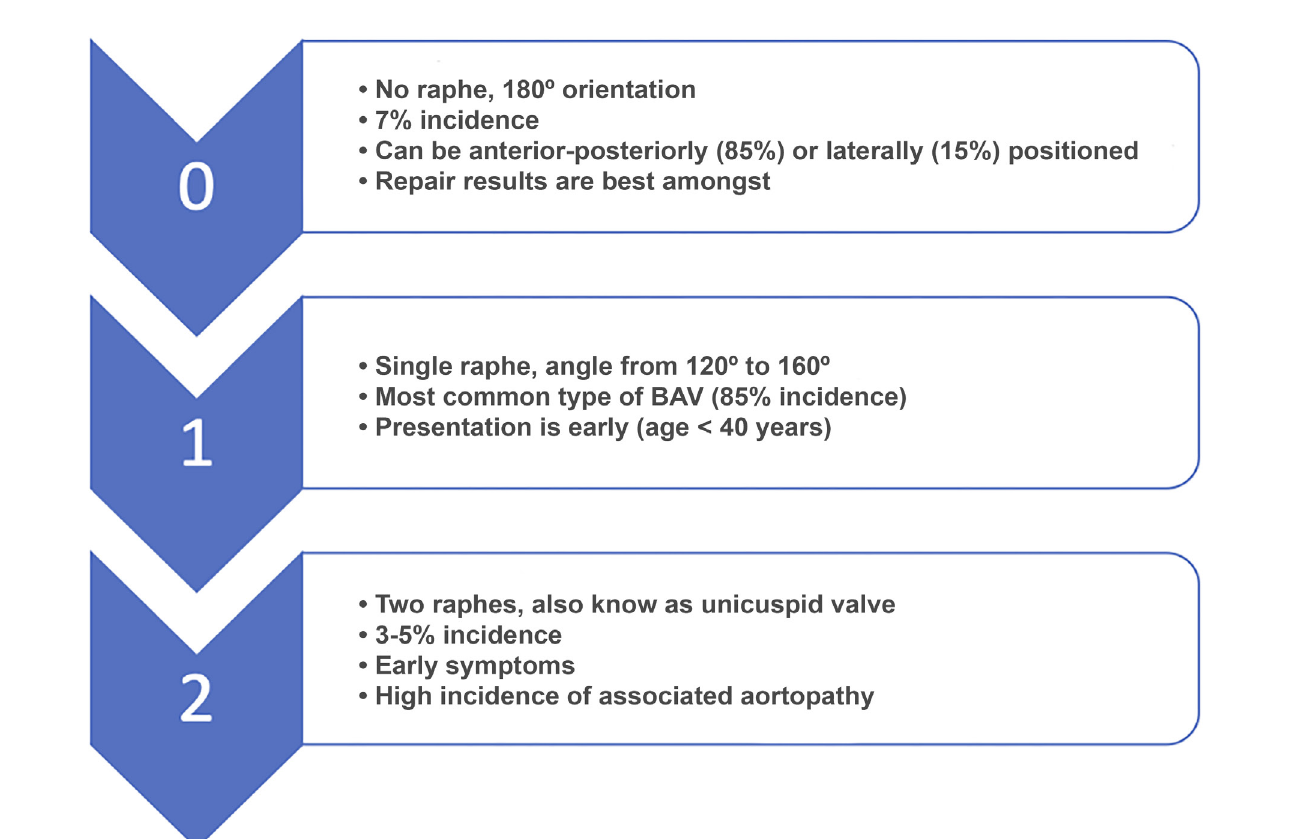
Fig. 2 - Bicuspid aortic valve classification. BAV=bicuspid aortic